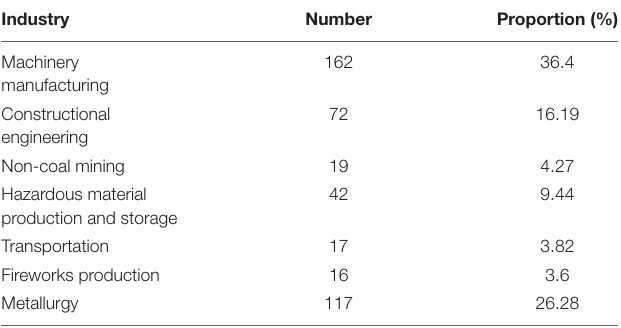
TABLE 3 | Industry distribution of the enterprises.